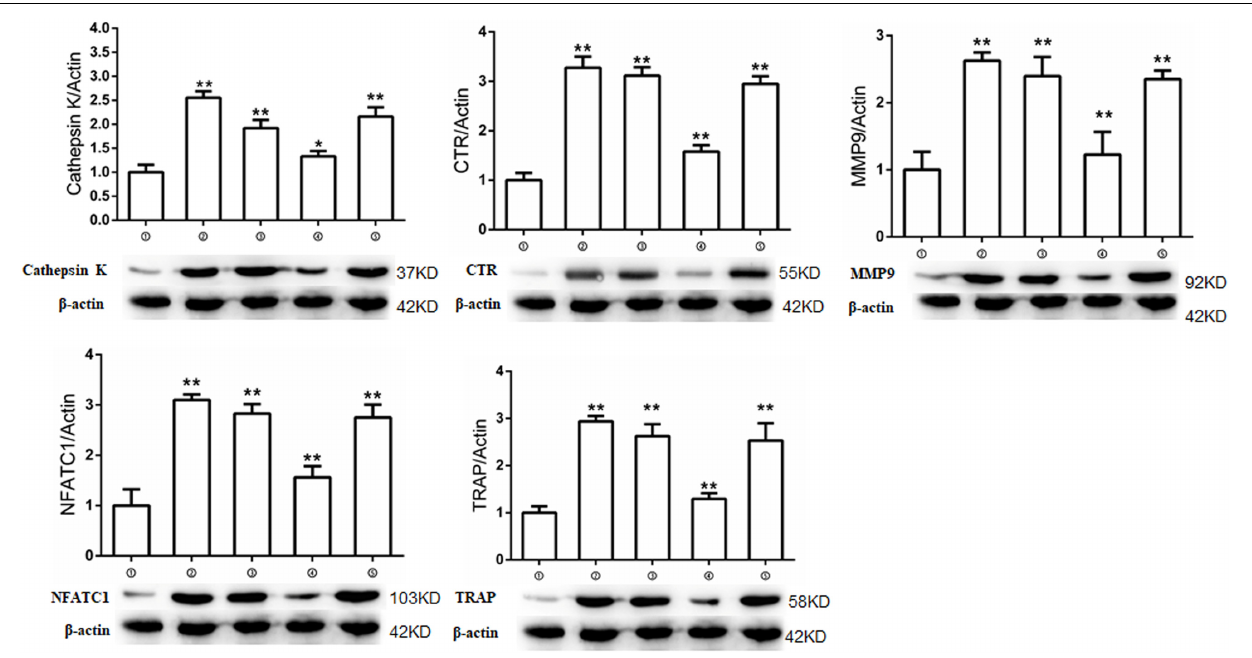
FIGURE 5 | RPS5 regulates expressions of osteoclastogenesis-related markers. Western blot and optical density analysis of expression of Cathepsin K, CTR, MMP-9, NFATc1, and TRAP with Beta actin as reference. (cid:172) RAW264.7 cells; (cid:173) RAW264.7 induced with M-CSF, RANKL and PBS; (cid:174) RAW264.7 cells infected with Lv-shRNA-RPS5 and induced with M-CSF, RANKL and PBS; (cid:175) RAW264.7 cells induced with M-CSF, RANKL and treated with 4 µ M M54; (cid:176) RAW264.7 cells infected with Lv-shRNA-RPS5, induced with M-CSF, RANKL and treated with 4 µ M M54. The membranes were cut according to the molecular size of the target protein and reincubated with primary antibodies but using the same loading control ( ∗∗ P < 0.01, ∗ P < 0.05 vs. (cid:173)